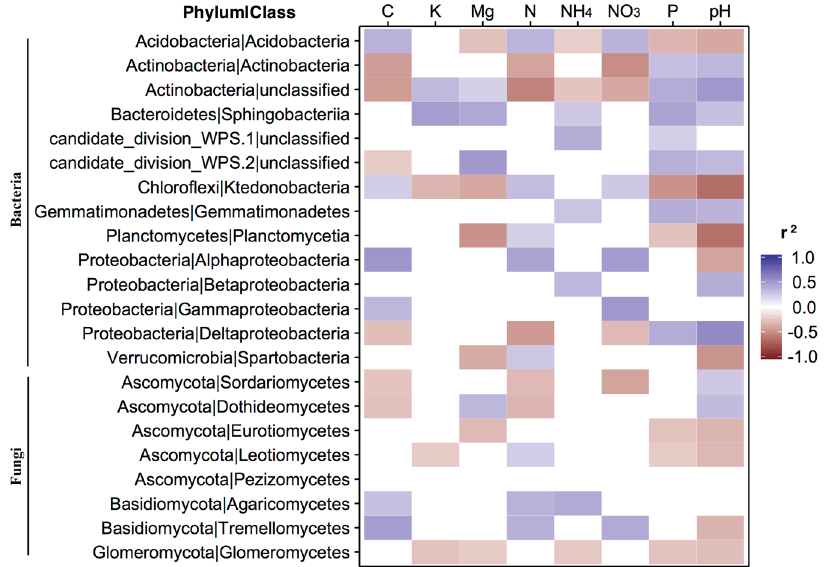
Figure 3. Correlation between soil properties (aggregate data for rhizosphere and bulk soils) and the different bacterial and fungal classes shown in Fig. 1. Significance level P <